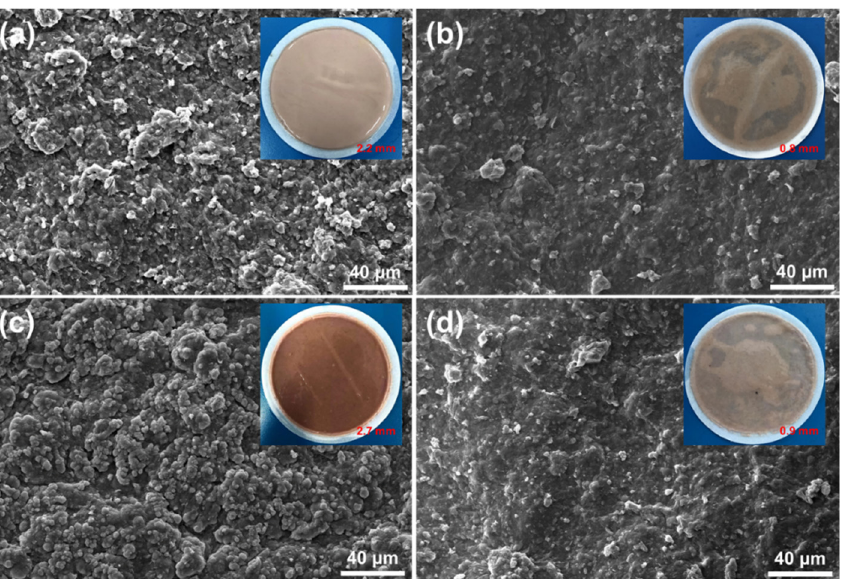
Figure 6. SEM and digital images of mud cakes deposited from different drilling fluids after aged at 180 °C for 16 h: ( a ) 4% bentonite WDF, ( b ) 4% bentonite + 1 wt% PAND WDF, ( c ) 4% bentonite + 30 wt% NaCl WDF, ( d ) 4% bentonite + 1 wt% PAND + 30 wt% NaCl WDF.